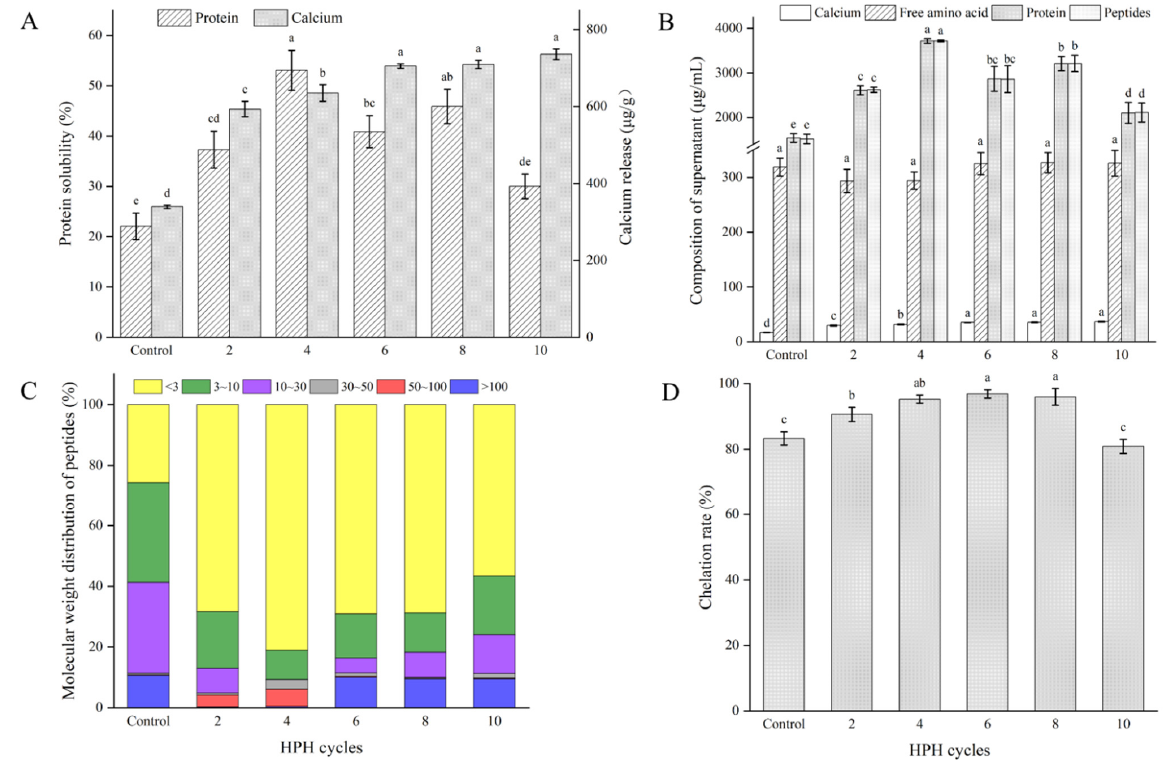
Figure 4. Solubility ( A ) and content ( B ) of the main components of RBAS after different HPH cycles. Molecular weight distributions of peptides ( C ) and chelation rate of peptide calcium ( D ) in RBAS treated with different HPH cycles.In figure, different lowercases in each group showed significant differences ( p < 0.05).